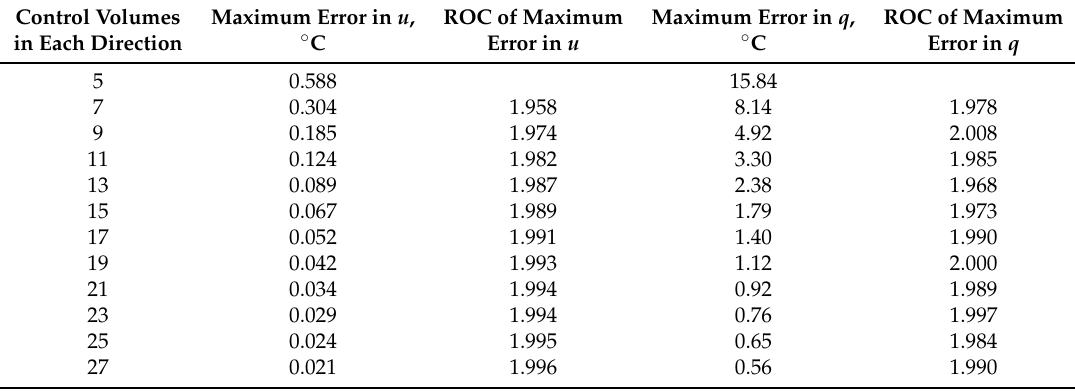
Table 1. Analysis of error convergence in the finite volume solution for decreasing discretization intervals. Rates of convergence (ROC) to a known analytical solution are expected to be